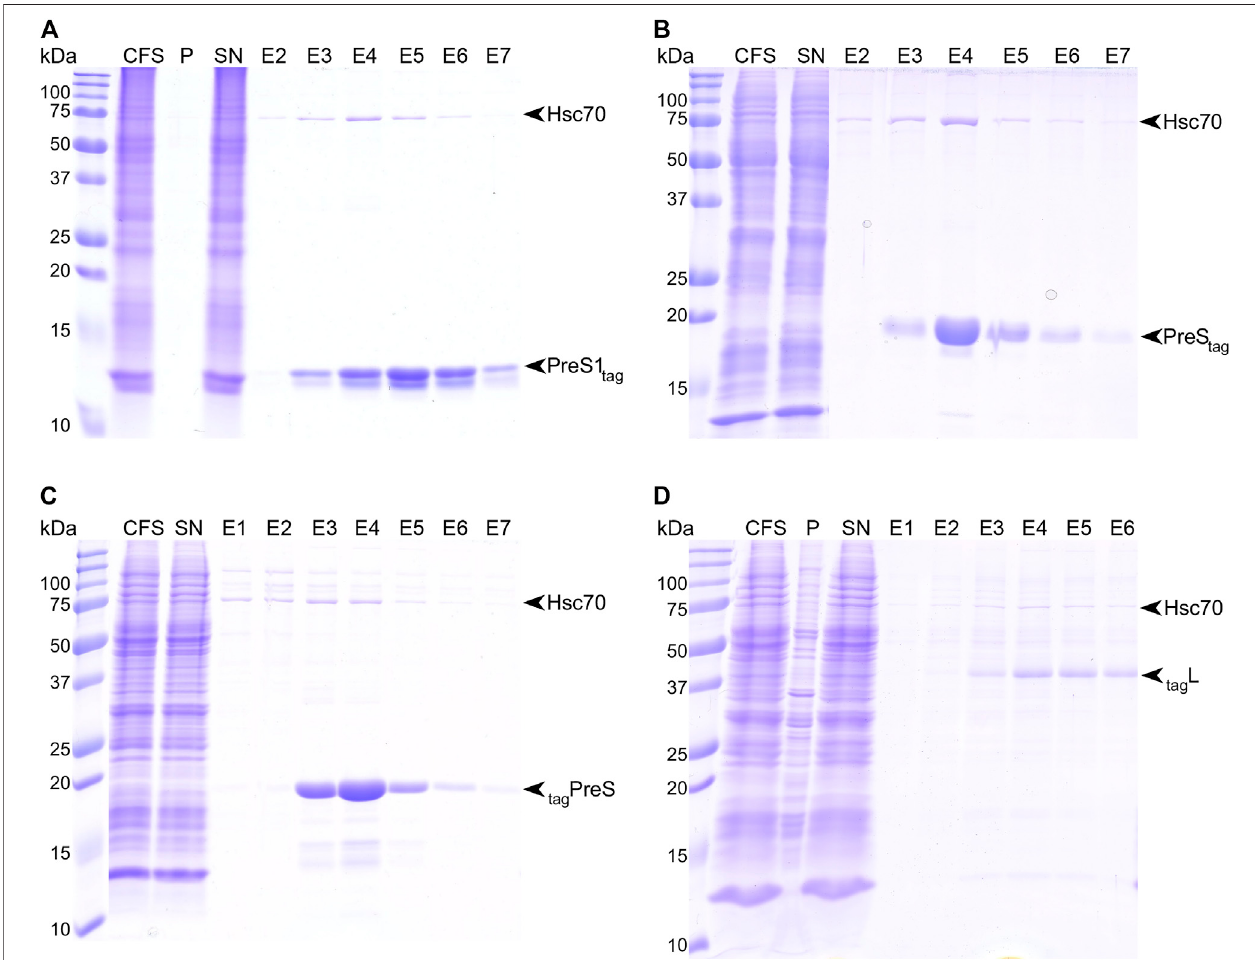
FIGURE1| Strep-Tactin©af fi nitypuri fi cationofPreS1tag (A) ,PreS tag (B) , tag PreS (C) ,and tag L (D) .Puri fi cationstepshavebeenanalyzedbySDS-PAGE,followed by Coomassie blue staining; CFS, total cell-free sample; P, pellet; SN, supernatant; E#, elution fractions.